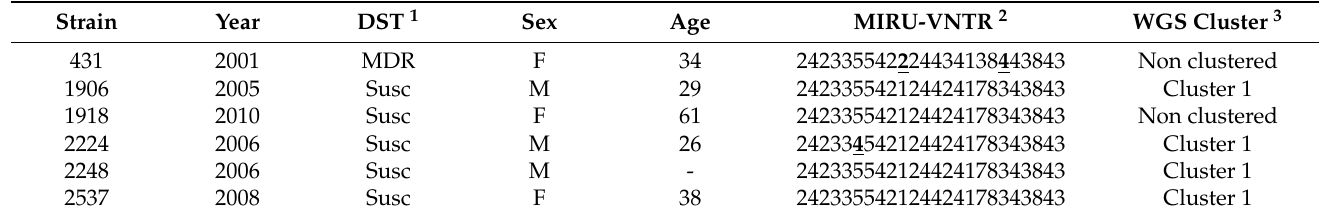
Table 1. Strain isolation year, drug-susceptibility test and sociodemographic characteristics associated with the mycobacterial interspersed repetitive unit—variable number of tandem repeats (MIRU- VNTR) and whole-genome sequencing (WGS) clustering analysis.